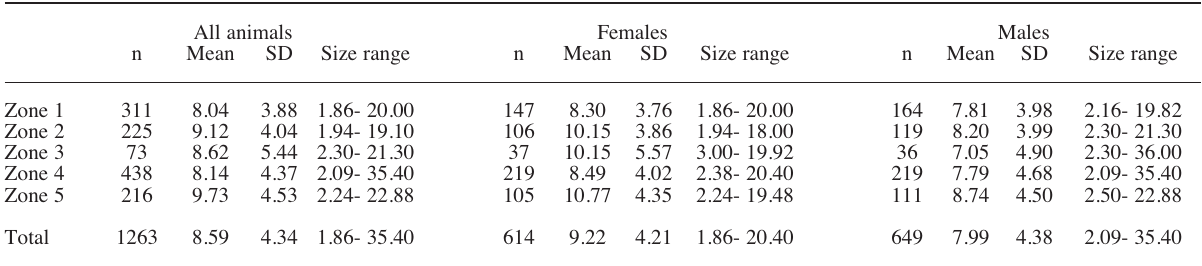
T ABLE 3. – Body size (carapace length in mm) of Microphrys bicornutus in the different sampling zones of Buchuaco (Venezuela); n= number of crabs; SD= standard deviation. All animals